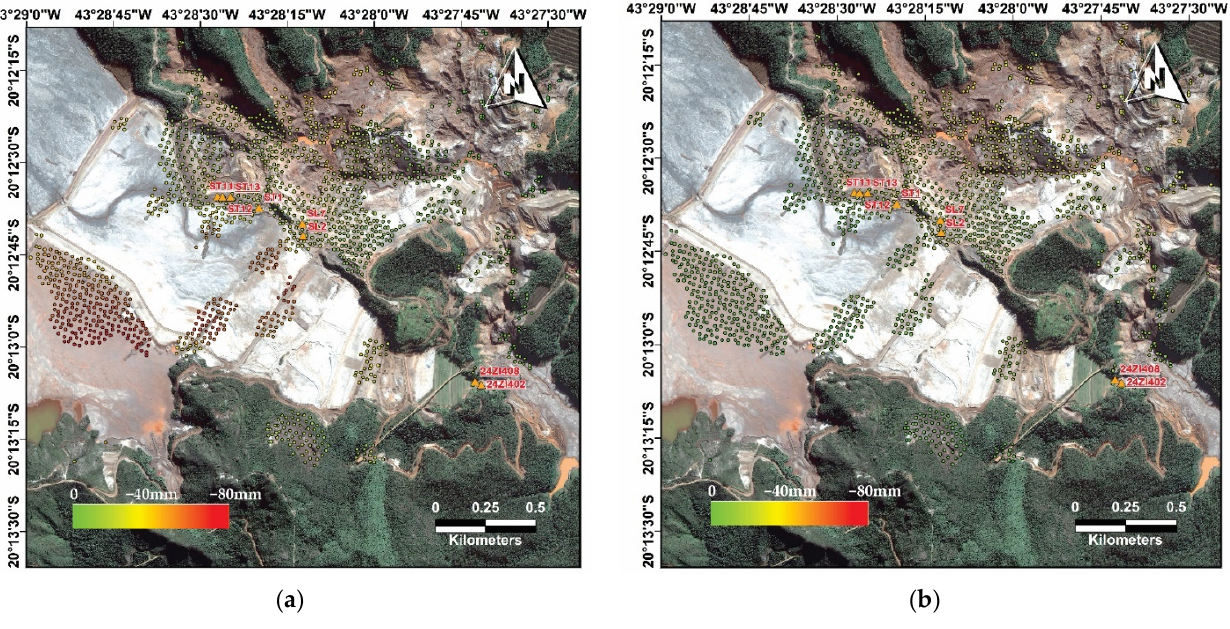
Figure 7. Maps of displacement: ( a ) Vertical, ( b ) Horizontal. The topographic survey (TS) values of vertical and horizontal directions, located on the Selinha dike (SL2, SL7), Sela–Tulipa dikes (ST1, ST11, ST12, ST13), and Germano main dam (24ZI402 and 24ZI408), and the corresponding MPs decomposed, in vertical and horizontal directions (vertical and horizontal) based on the S1 and TSX data, can be seen in the plots of Figures 8 and 9. Additionally, the MPs of S1 and TSX in LoS were projected to the vertical and horizontal directions based on Equations (2) and (3), according to Figure 3a [47], these final values are described as S1-Proj and TSX-Proj in Figures 8 and 9.